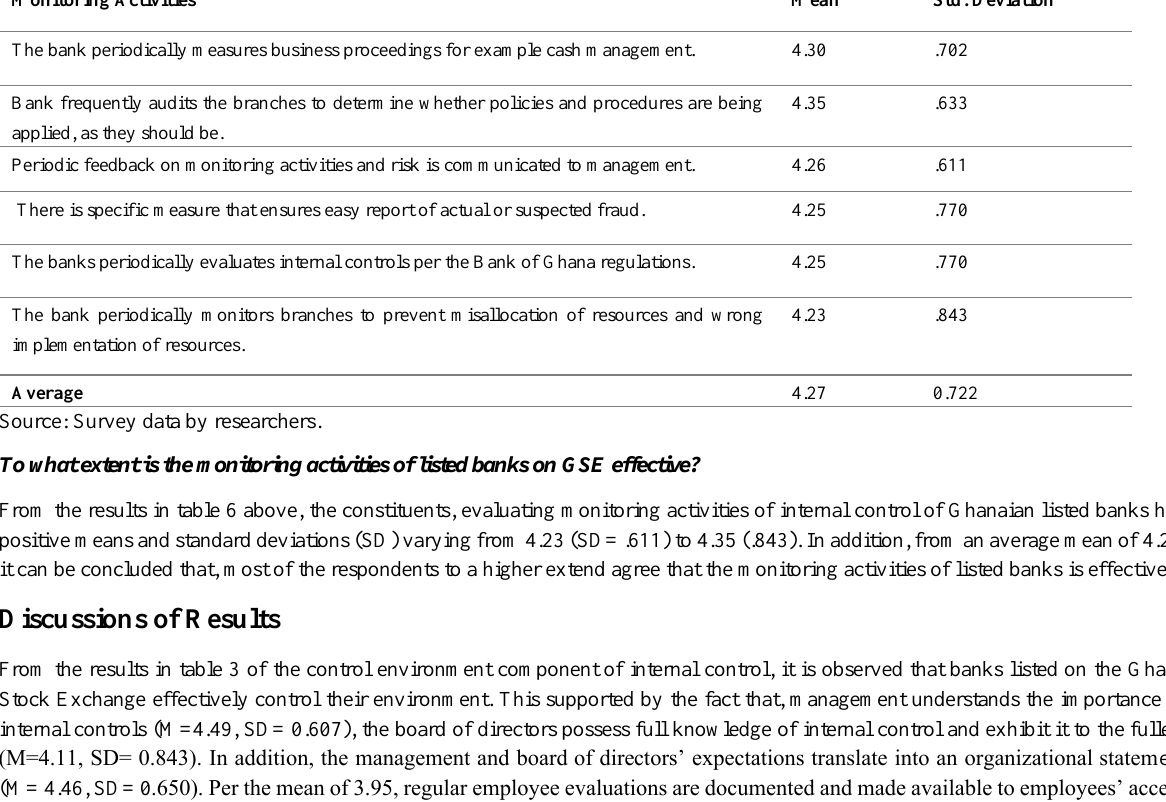
Table 6: Means, standard deviation for Monitoring Component of COSO Monitoring Activities Mean Std.